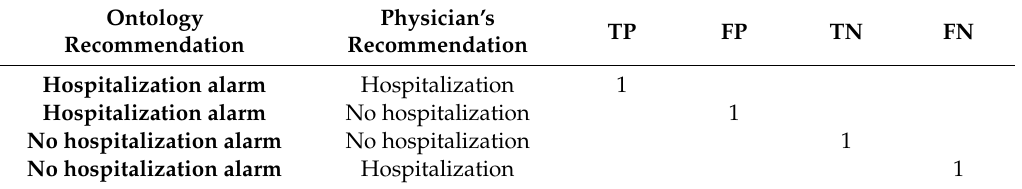
Table 14. The confusion matrix.